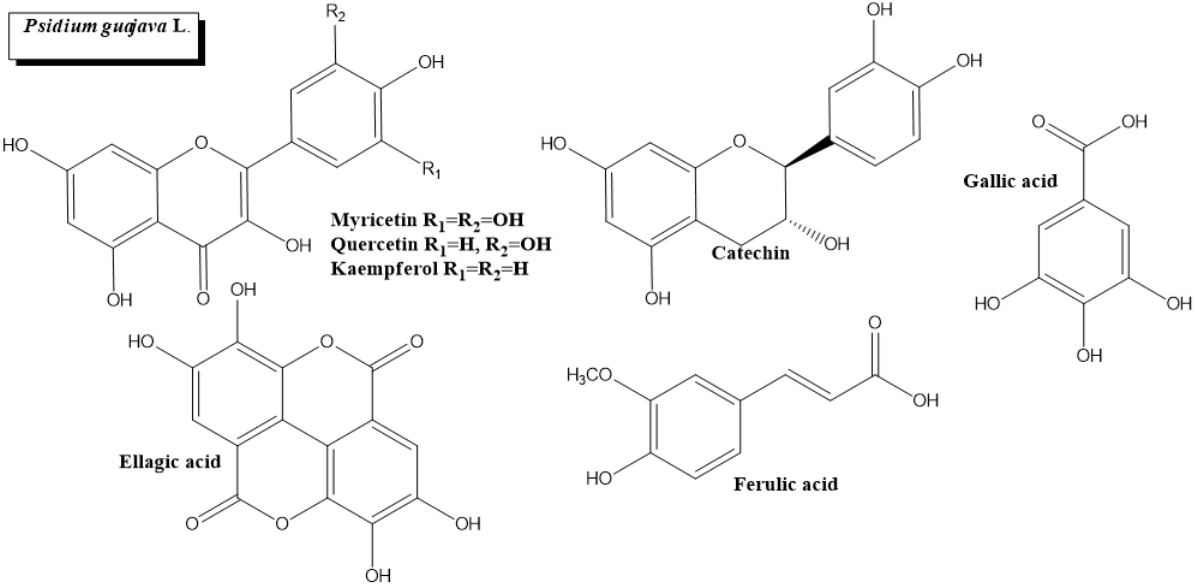
Figure 6. Chemical structures of bioactive phytocompounds with reported antidiabetic properties identified in Psidium guajava L. identified in Psidium guajava